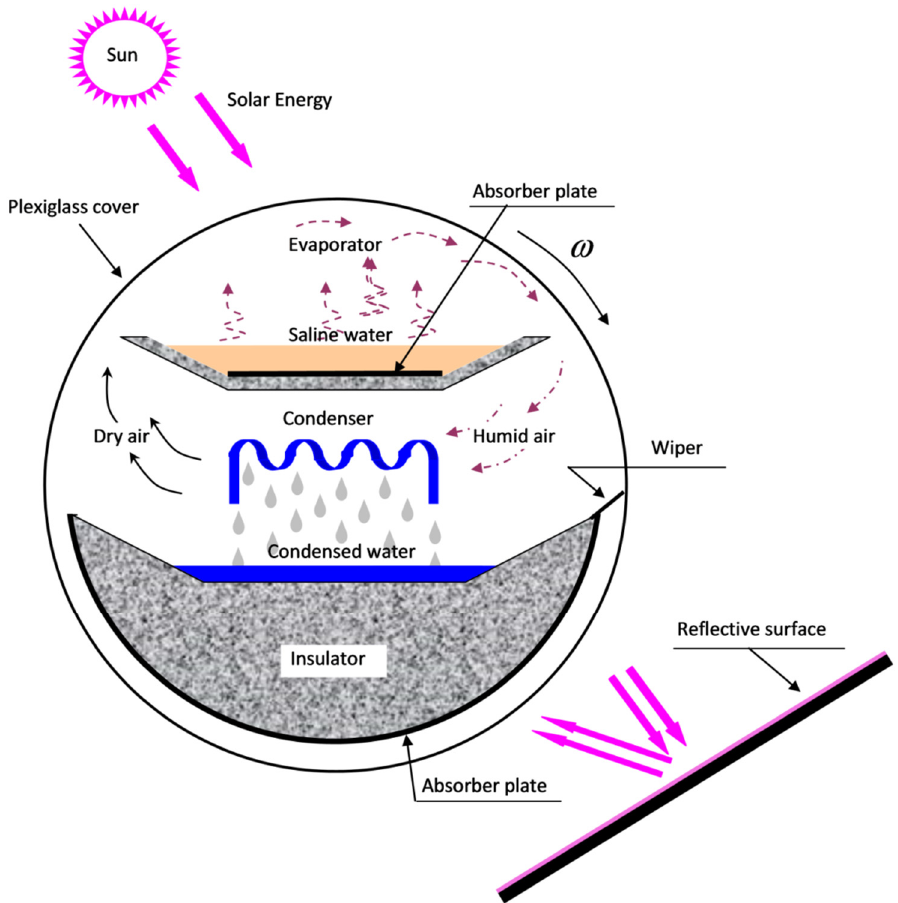
Figure 1. Original solar still design.